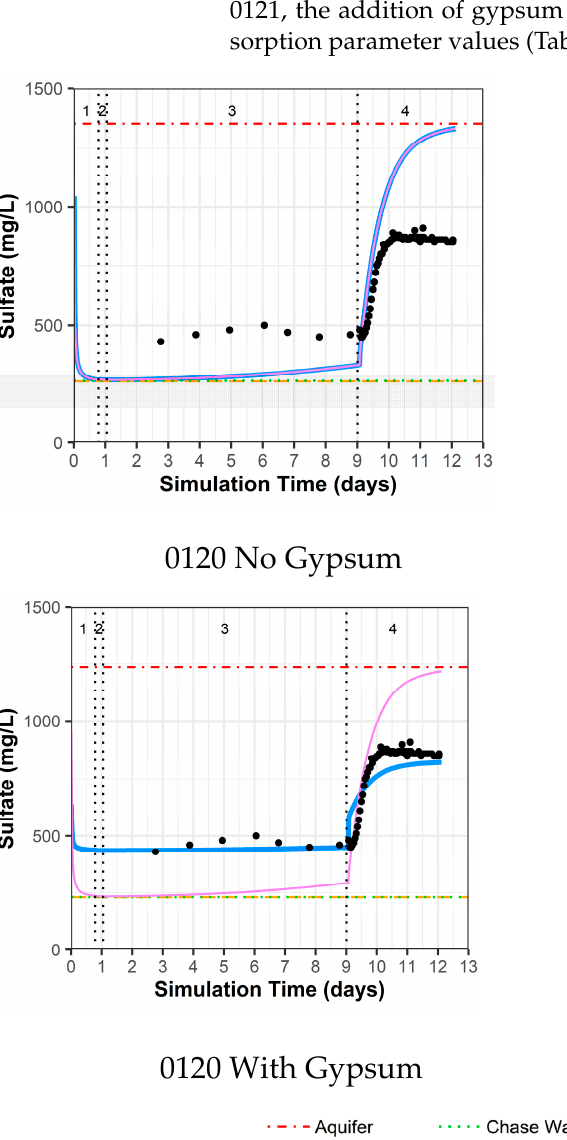
Figure 8. Model fit for sulfate with a multilayer approach. Phases are: (1) traced river water injection, (2) untraced river water injection (chase), (3) drift phase, and (4) pumping phase.